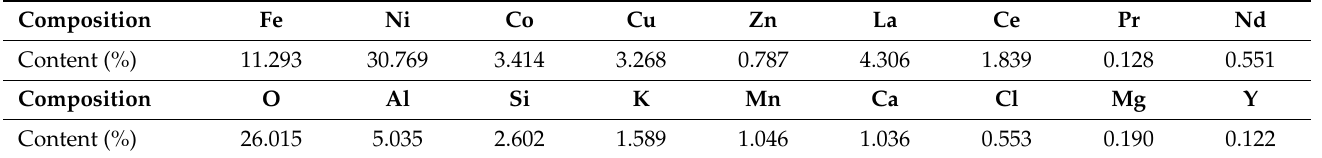
Table 1. Chemical composition of battery black mass (%).